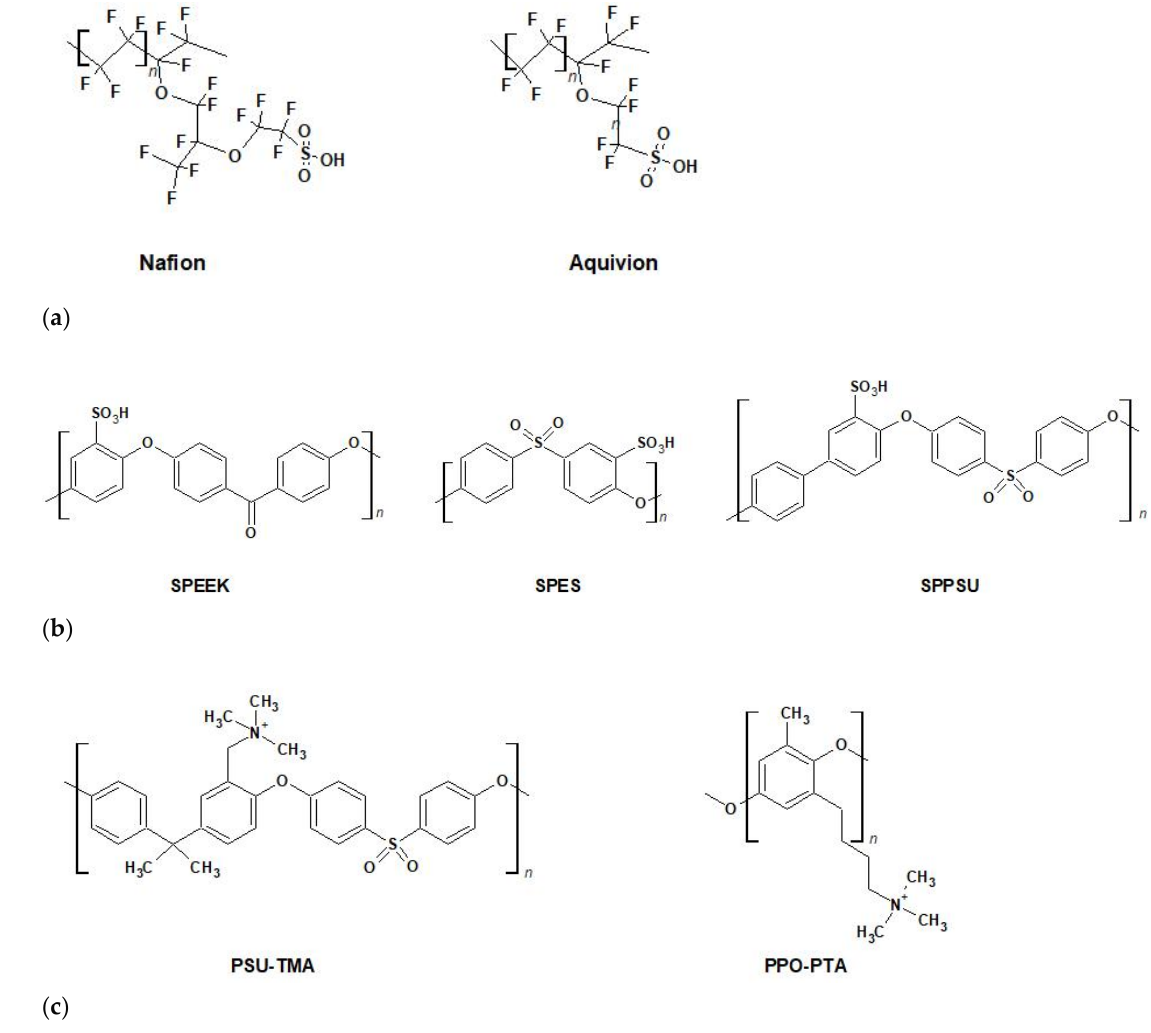
Figure 6. ( a ) Long side-chain perfluorosulfonic acid Nafion 1100 ( n = 6.6) and short side-chain Aquivion 830 ( n = 5.5). ( b ) Sulfonated aromatic polymers. ( c ) Anion exchange polymers: poly(sulfone trimethylammonium) (PSU-TMA) and poly(phenylene oxide pentyltrimethylammonium) (PPO-PTA).